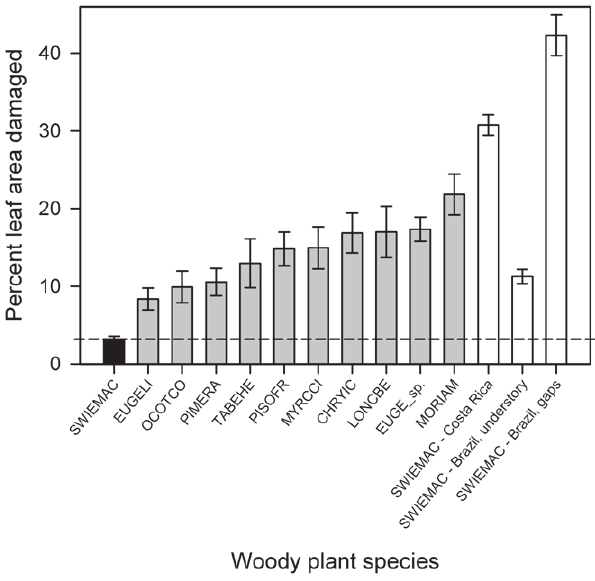
Figure 1. Mean leaf herbivory on juveniles of the introduced big-leaf mahogany ( Swieteniamacrophylla =SWIEMAC, the black bar) and 10 co-occurring woody plant species in Cabrits National Park, Dominica. Not shown because of too small a sample size is introduced small-leaf mahogany ( S. mahagoni ), which had an average ( 6 SE) of 9.65% 6 3.14 ( n =4 plots). Sample sizes for the 11 species bars were from left to right: 20, 14, 30, 22, 9, 25, 11, 19, 9, 25, and 17 plots, respectively. For comparison, in white bars at the far right, are shown mean ( 6 SE) levels of herbivory for planted seedlings in semi-evergreen and deciduous secondary forest in Costa Rica (calculated from n =18 data points in Figure 2c in [61]), for n =304 wild seedlings in the understory of an unlogged Amazonian forest [44], and for 168 seedlings planted in n =14 small canopy gaps in the same forest [45]. Species are listed in Table 1.